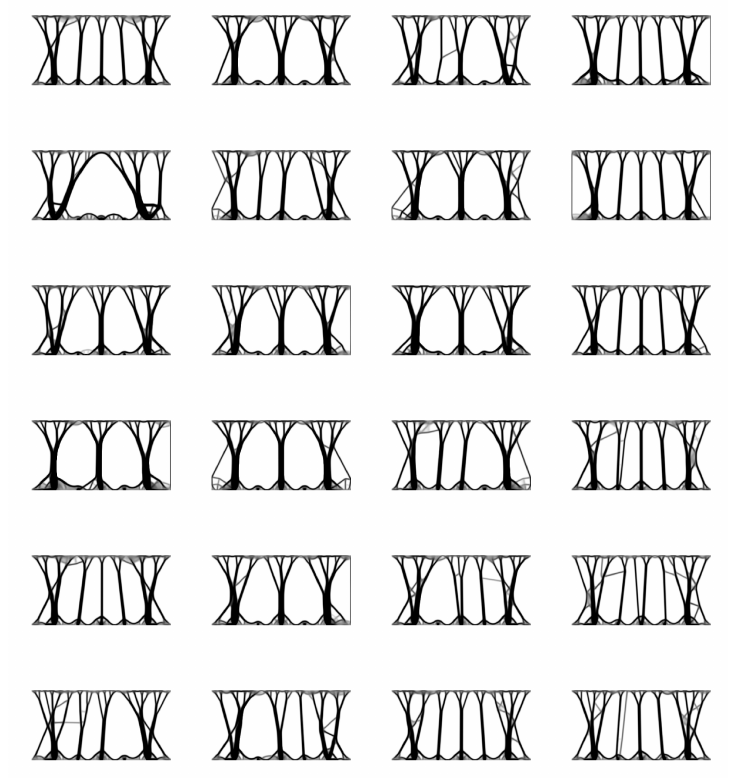
Figure 10. Results for test example